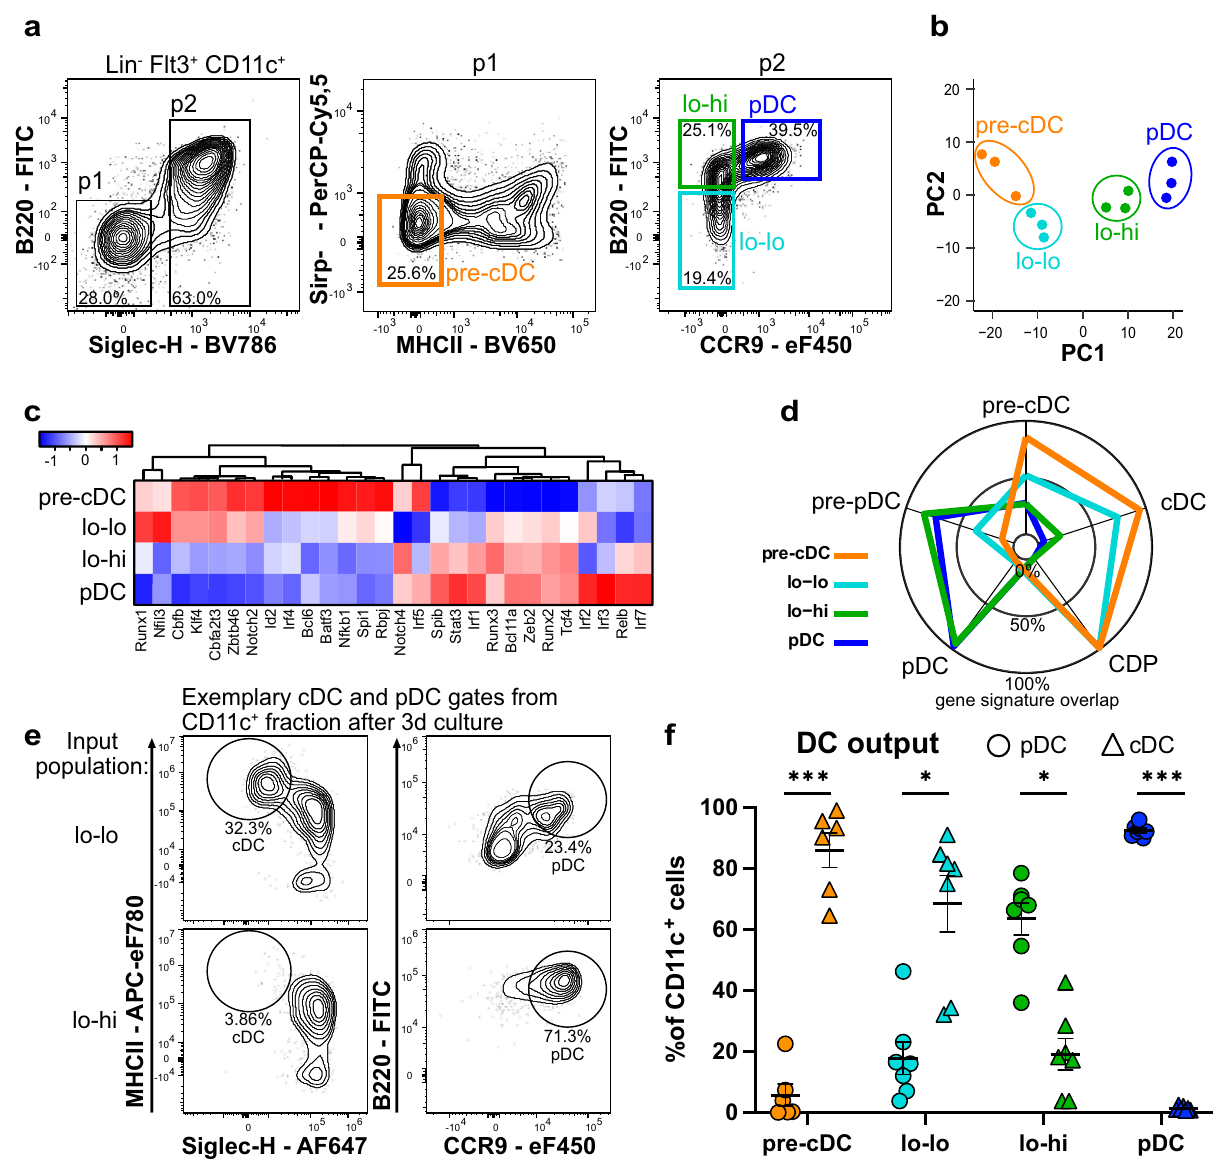
Fig. 1 Relationship of Siglec-H + CCR9 lo B220 hi cells and pDCs. a Gating strategy for Siglec-H – pre-cDC, Siglec-H + CCR9 lo B220 lo (lo-lo), CCR9 lo B220 hi (lo- hi) and CCR9 hi B220 hi pDCs. The indicated populations were sorted from the BM cells of 3 individual C57BL/6 mice and processed for RNA-sequencing. b Principal component analysis performed on normalized counts using all genes. c Expression heatmap of selected TFs, z-score hierarchical clustering by Euclidean distances (normalized counts). d Gene signatures of the sorted populations compared to previously published gene signatures of pre-cDC, cDC, CDP, pDC and pre-pDC 39 . Distance from the middle of the radar plot indicates the percentage of overlap between genes of sorted populations that showed higher expression than the inter-population median and the indicated gene signatures. e Gating strategy for pDC/cDC output after culturing precursor cells. cDCs were identi fi ed as Siglec-H – MHCII hi cells and pDCs as Siglec-H + CCR9 hi B220 hi cells within CD45 + CD11c + cells. f Siglec-H – pre-cDC, lo-lo and lo-hi precursors, and pDC were sorted from Lineage-depleted BM cells of WT mice as shown in ( a ) and cultured for 3 days on EL08-1D2 stromal cells in Flt3L-containing medium. The percentages of cells with a phenotype of pDC (circles) or cDC (triangles) within CD11c + progeny of the indicated input populations is shown as mean ± SEM ( n = 7) and was compared using paired, two-sided t-tests with Holm- Š ídák correction for multiple testing. Adjusted p -values: <0.05(*), <0.005(**),